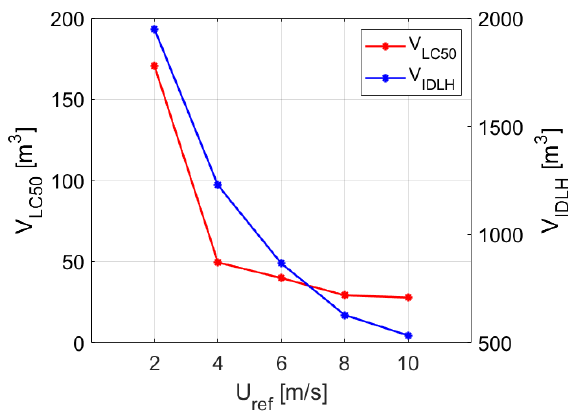
Figure 16. V IDLH and V LC50 as a function of U ref .